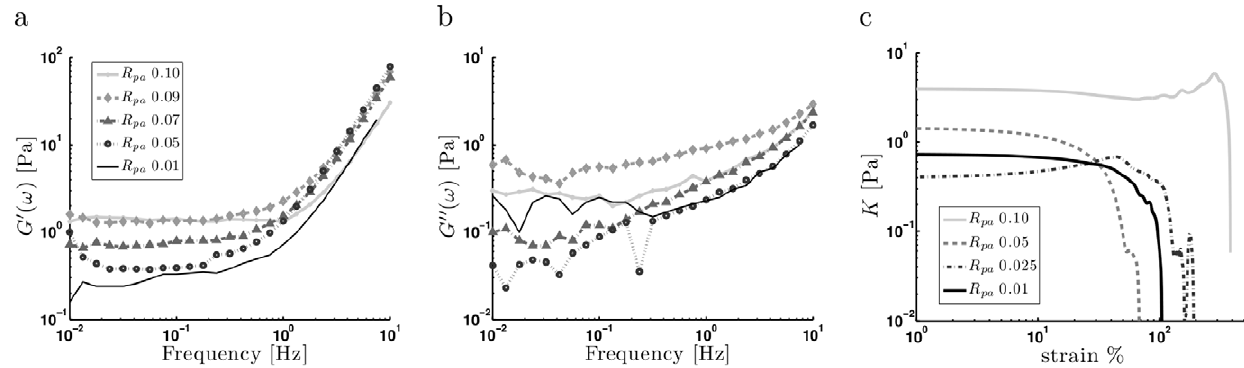
Figure 3. Viscoelastic properties of actin/palladin networks. (a) Storage moduli and (b) loss moduli of 10 m M actin networks crosslinked with different concentrations of palladin. The legend is same for (a) and (b). The storage modulus is weakly sensitive to frequency at low frequencies and changes around 1 Hz to a power law relation, G ’* v 2 . Above 1 Hz the loss modulus tends towards G ’’* v . (c) Differential moduli of 10 m M actin networks. No significant non-linear behavior is observed in these networks for any palladin concentrations.